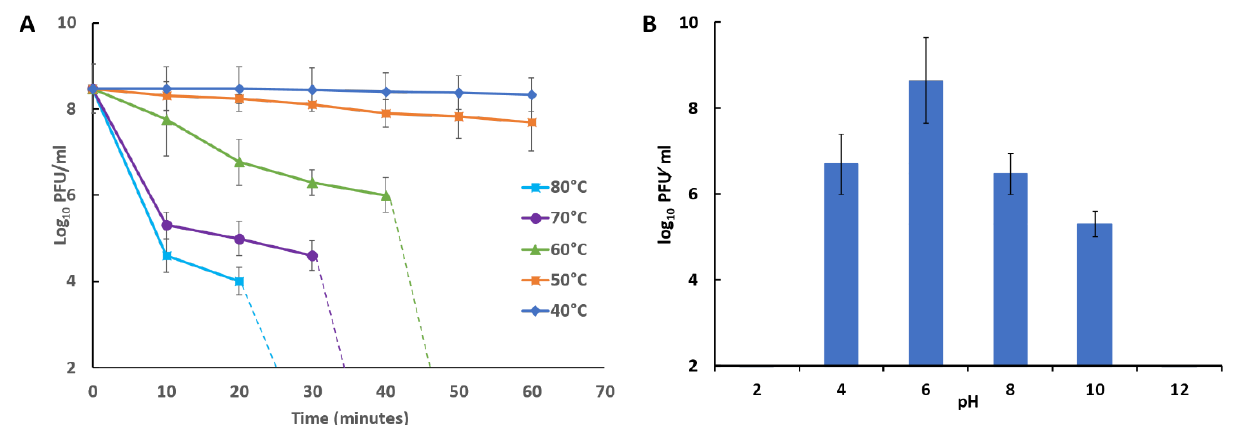
Figure 5. ( A ) Temperature and ( B ) pH stability of E. faecalis phage vB_ZEFP.